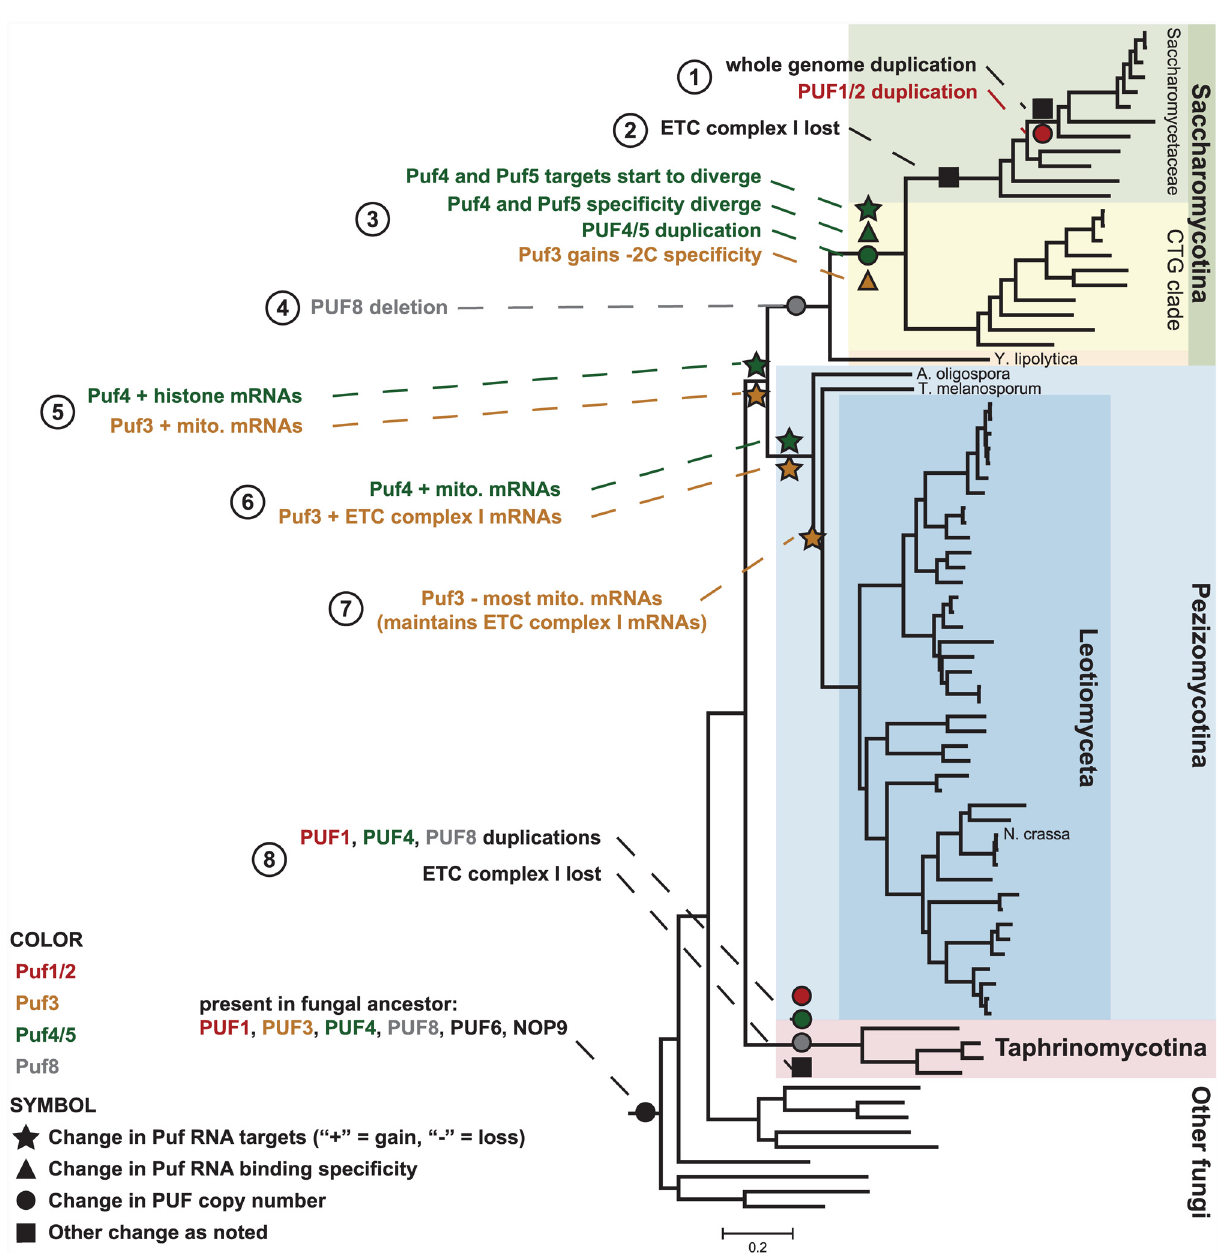
Fig 8. Phylogenetic model for changes in Puf proteins and their RNA interactions throughout fungal evolution. Symbols indicate the type of change, and colors link the indicated event to a particular Puf protein.